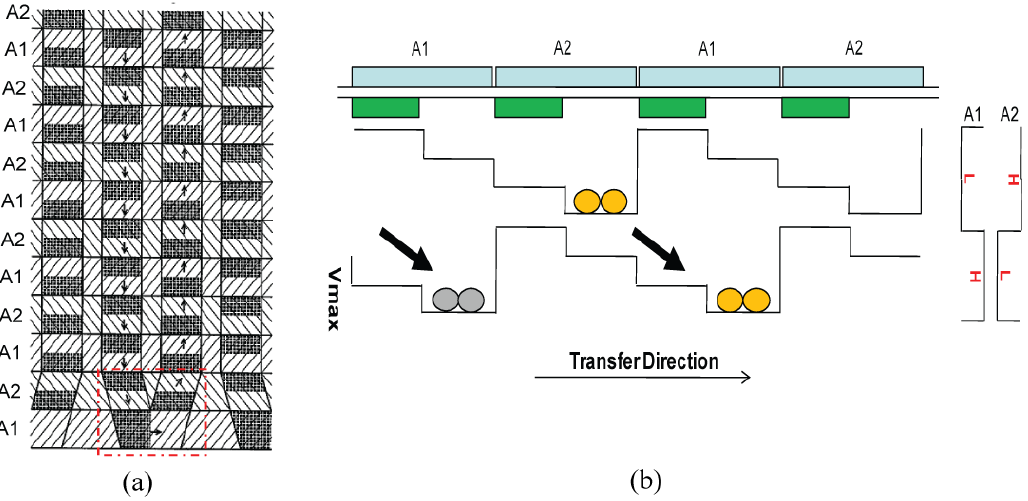
Figure 6. Scheme for direction change for two-phase transfer: (a) Configuration of electrodes and barriers; (b) Transfer